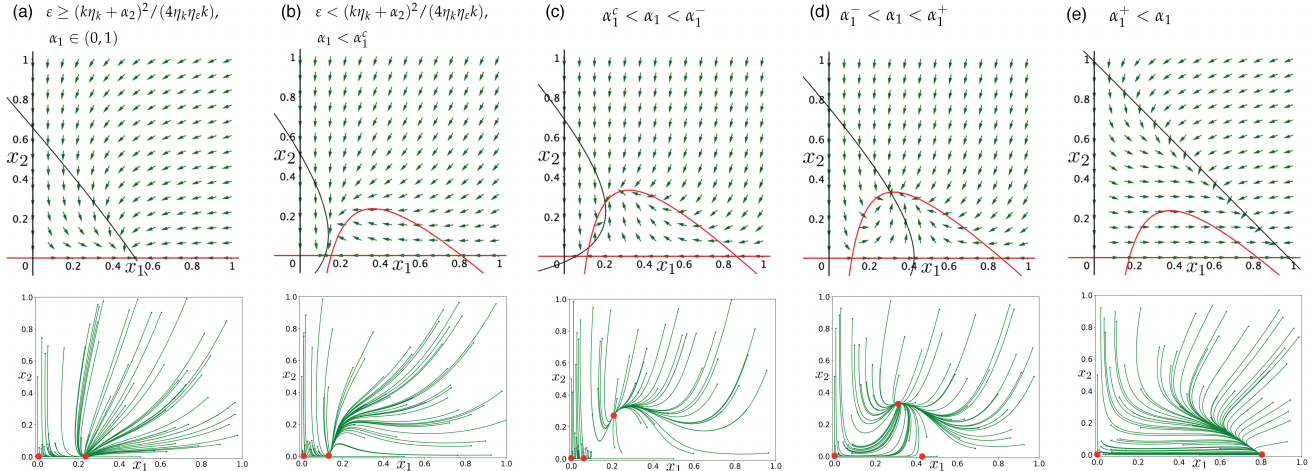
Figure 4. The direction of the dynamical system vector field for all possible situations regarding α 1 > ε and α 2 < η ε ε . Below, we display a phase portrait of the system in the five possible situations studied. Specifically, the plots have been obtained using the following parameters: ( a ) α 1 = 0.3, α 2 = 0.18, ε = 0.23, k = 0.29, η k = 5.5, η ε = 2.3; ( b ) α 1 = 0.24, α 2 = 0.05, ε = 0.21, k = 0.37, η k = 4.3, η ε = 1.2; ( c ) α 1 = 0.34, α 2 = 0.13, ε = 0.32, k = 1, η k = 7.5, η ε = 2.75; ( d ) α 1 = 0.56, α 2 = 0.13, ε = 0.32, k = 1, η k = 7.5, η ε = 2.75; ( e ) α 1 = 0.86, α 2 = 0.14, ε = 0.17, k = 0.29, η k = 7.5, η ε =